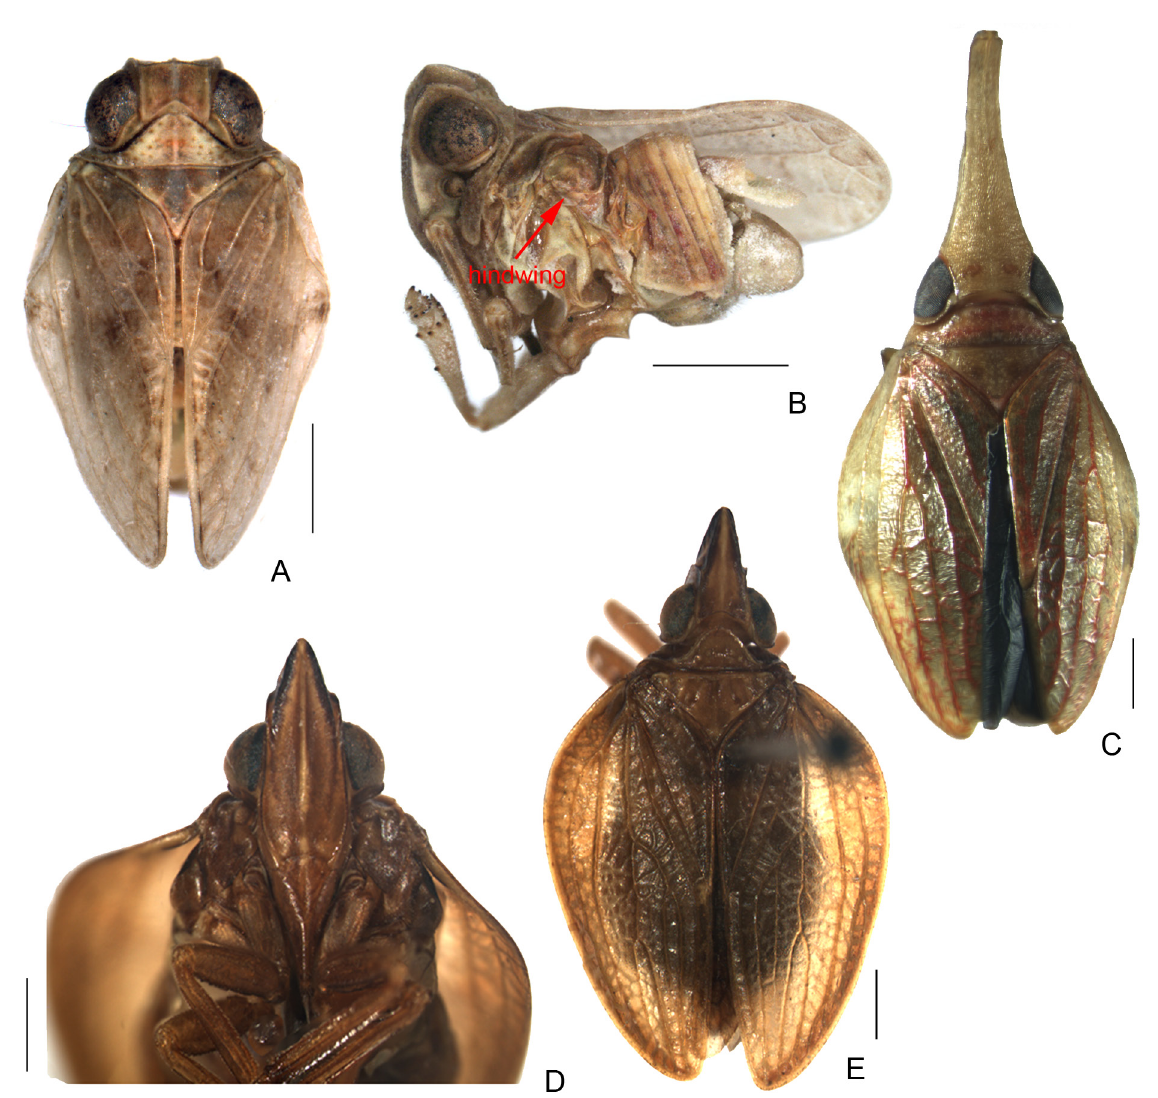
Fig. 1. A . Celyphoma quadrupla Meng & Wang, 2012, holotype, ♂, habitus, dorsal view. B . Same, lateral view. — C . Pseudochoutagus curvativus Che, Zhang & Wang, 2011, holotype, ♂, habitus, dorsal view. — D . Macrodarumoides petalinus Che, Zhang & Wang, 2012, holotype, ♂, frons and clypeus. E . Same, dorsal view. Scale bars = 1